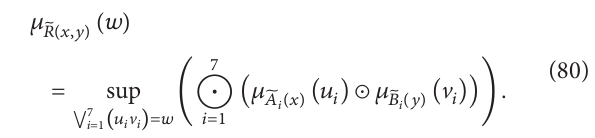
Example 3. Choose ⊔ (∨,⋆